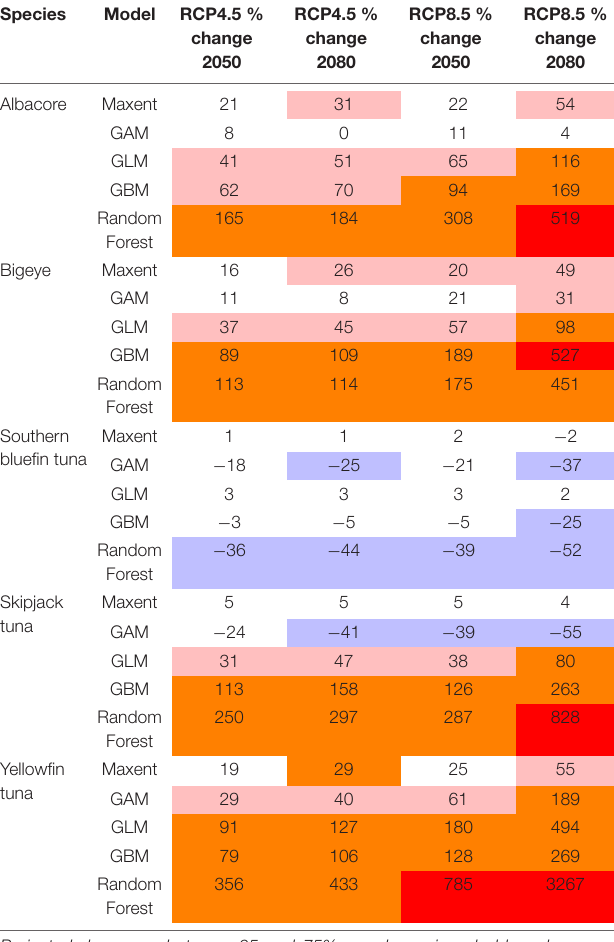
TABLE 1 | The projected changes in habitat suitability in the Tristan da Cunha EEZ for each species, for each model.